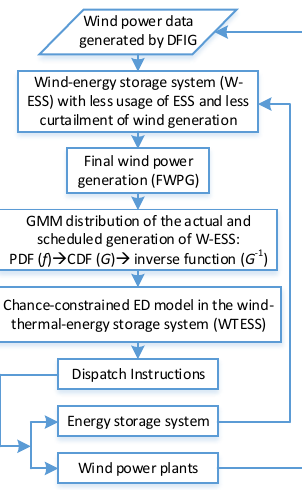
Figure 2. Framework of the economic dispatch system incorporating wind generation and ESS with the application of the GMM distribution.